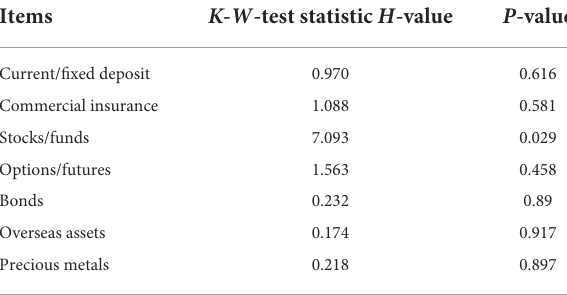
TABLE 5 Median household financial asset allocation over time. TABLE 6 Differences in household financial asset allocation by period.